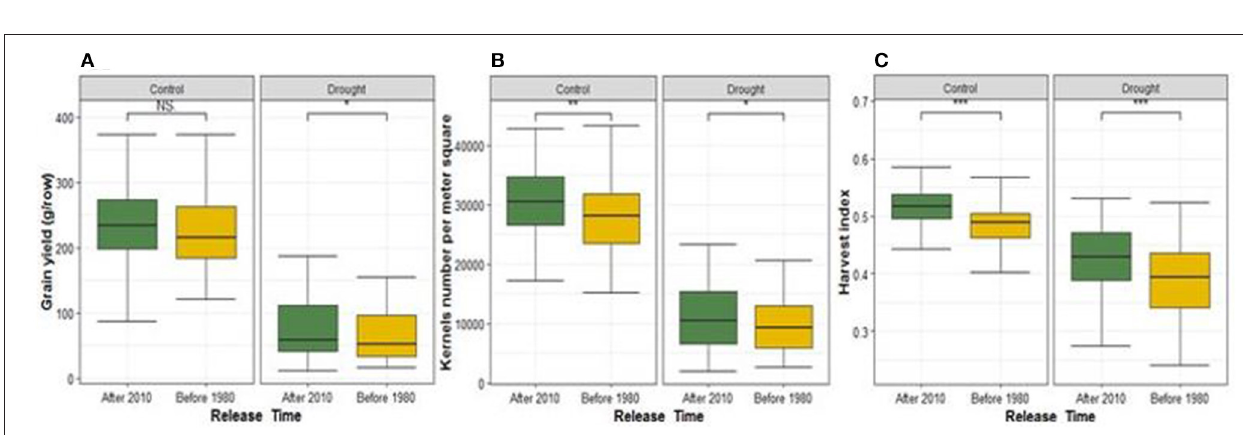
FIGURE 2 | Comparison of breeding progress in agronomic and grain quality traits between two contrasting years of release groups under rainfed (control) and drought stress conditions. The oldest cultivars were released before 1980 (gold color) while the modern were released after 2010 (dark green). (A–C) are illustrating the comparison of GY, KN, and HI, respectively. NS means the P -value is not significant and *, **, *** mean P -value is significant at 0.05, 0.01 and 0.001,